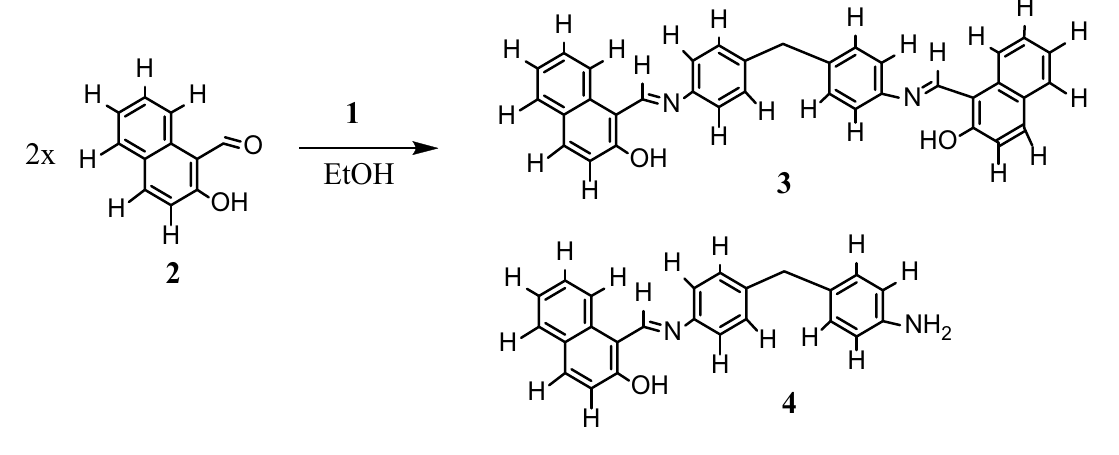
Figure 3. Chemical synthesis of the ligand mixture (3,4).